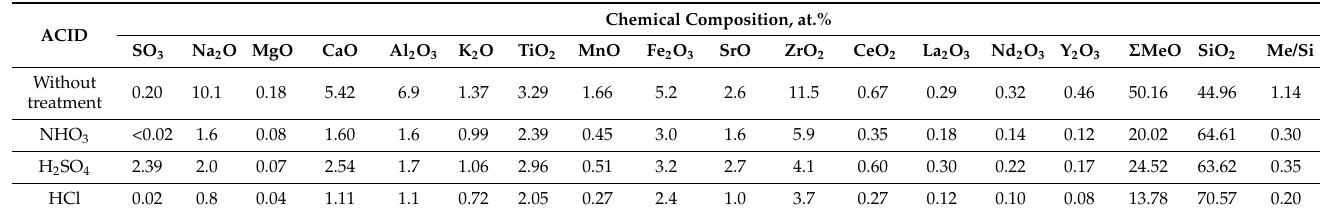
Table 7. XRF results of the concentrate before the treatment and after leaching with various acids. Chemical Composition, at.%